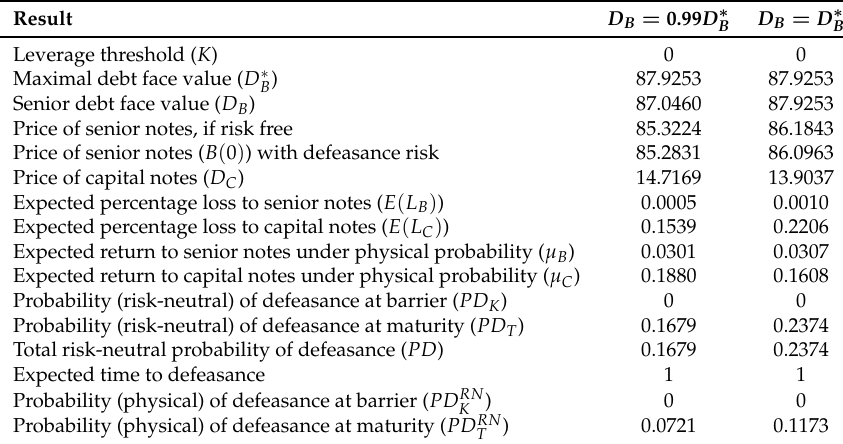
Table 2. Results for the special investment vehicles (SIV) when no leverage controls are imposed, i.e., K = 0. Results are shown for the case when senior debt is at its maximal amount, D ∗ percentage losses on senior debt ( E ( L B ) ) equal to L 0 = 0.0010 (10 bps). Results are also shown for the case where senior debt is set to 99% of the maximal amount.